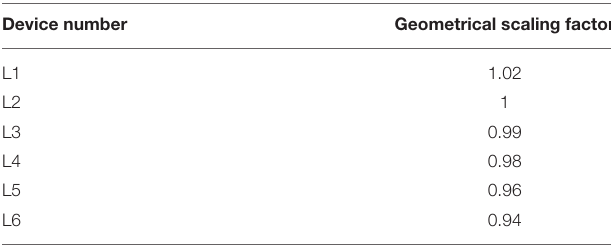
TABLE 1 | Scaling of the geometrical parameters reported in Figure 1